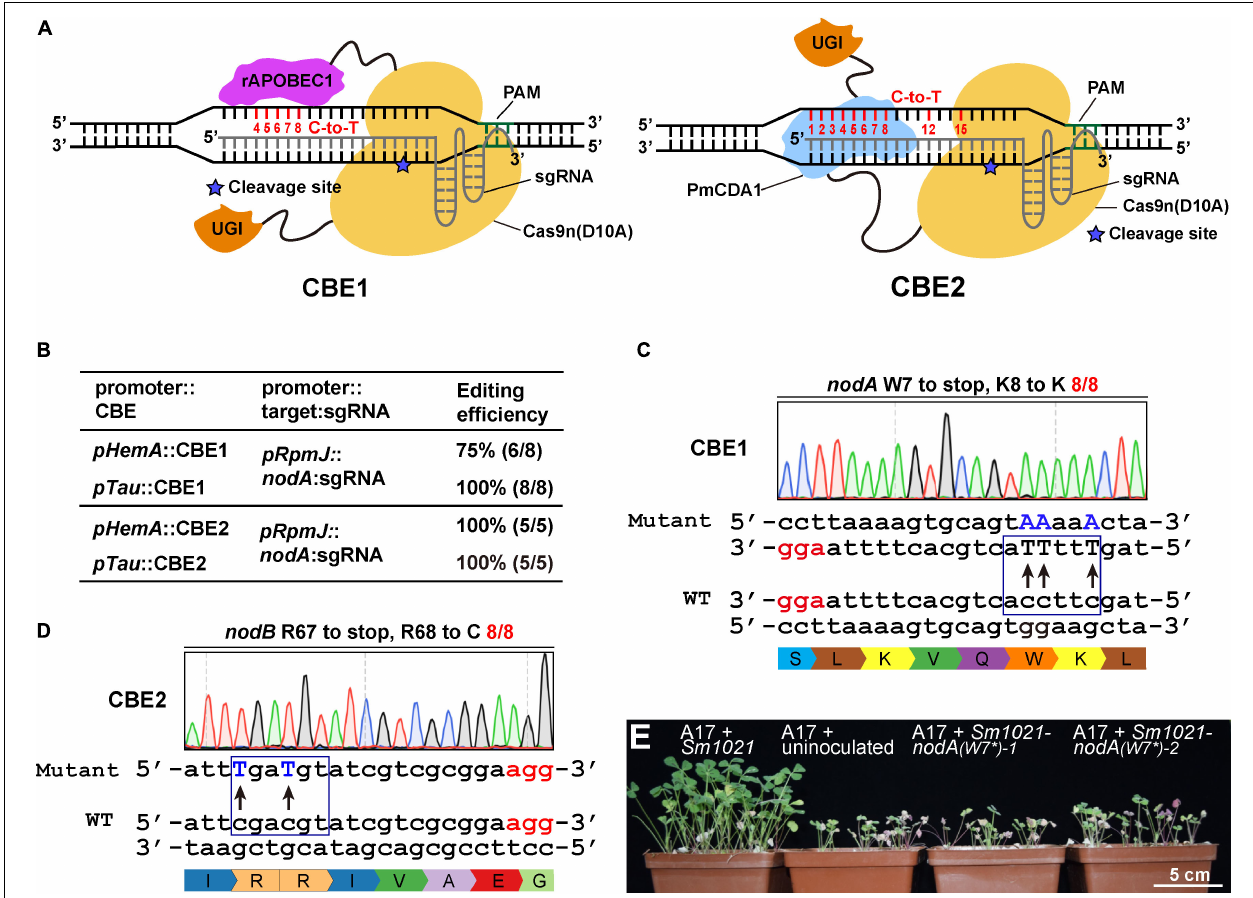
FIGURE 2 | Cytidine base editor (CBE) systems enable efficient C-to-T conversion in S. meliloti . (A) Schematic diagram of two typical cytidine base editors (CBEs). The CBE1 base editor contains the rat APOBEC1(rAPOBEC1) cytidine deaminase and the Uracil DNA glycosylase inhibitor (UGI) fused to the N-terminus and C-terminus of the SpCas9 nickase (Cas9n D10A), respectively. The CBE2 base editor contains the activation-induced cytidine deaminase (AID) ortholog PmCDA1 and UGI proteins fused to the C-terminus of the Cas9 nickase. The potential editable sites of the CBE systems are highlighted in red. The asterisk indicates the cleavage site of Cas9n nickase. (B) Editing efficiency comparison of various combinations of CBEs, promoters, and sgRNAs. (C) Conversion of the codon encoding the W7 residue of the nodA gene in S. meliloti to a stop codon. The conversion efficiency was 8/8. The mutated sites are colored blue. The PAM sites are colored red. (D) Conversion of the codons encoding R67 and R68 in the nodA gene in S. meliloti to stop codons and codons encoding R. The conversion efficiency was 12/12. (E) Growth phenotype of Medicago truncatula . Under nitrogen limiting conditions, host plants exhibited robust vegetative growth 4 weeks after they